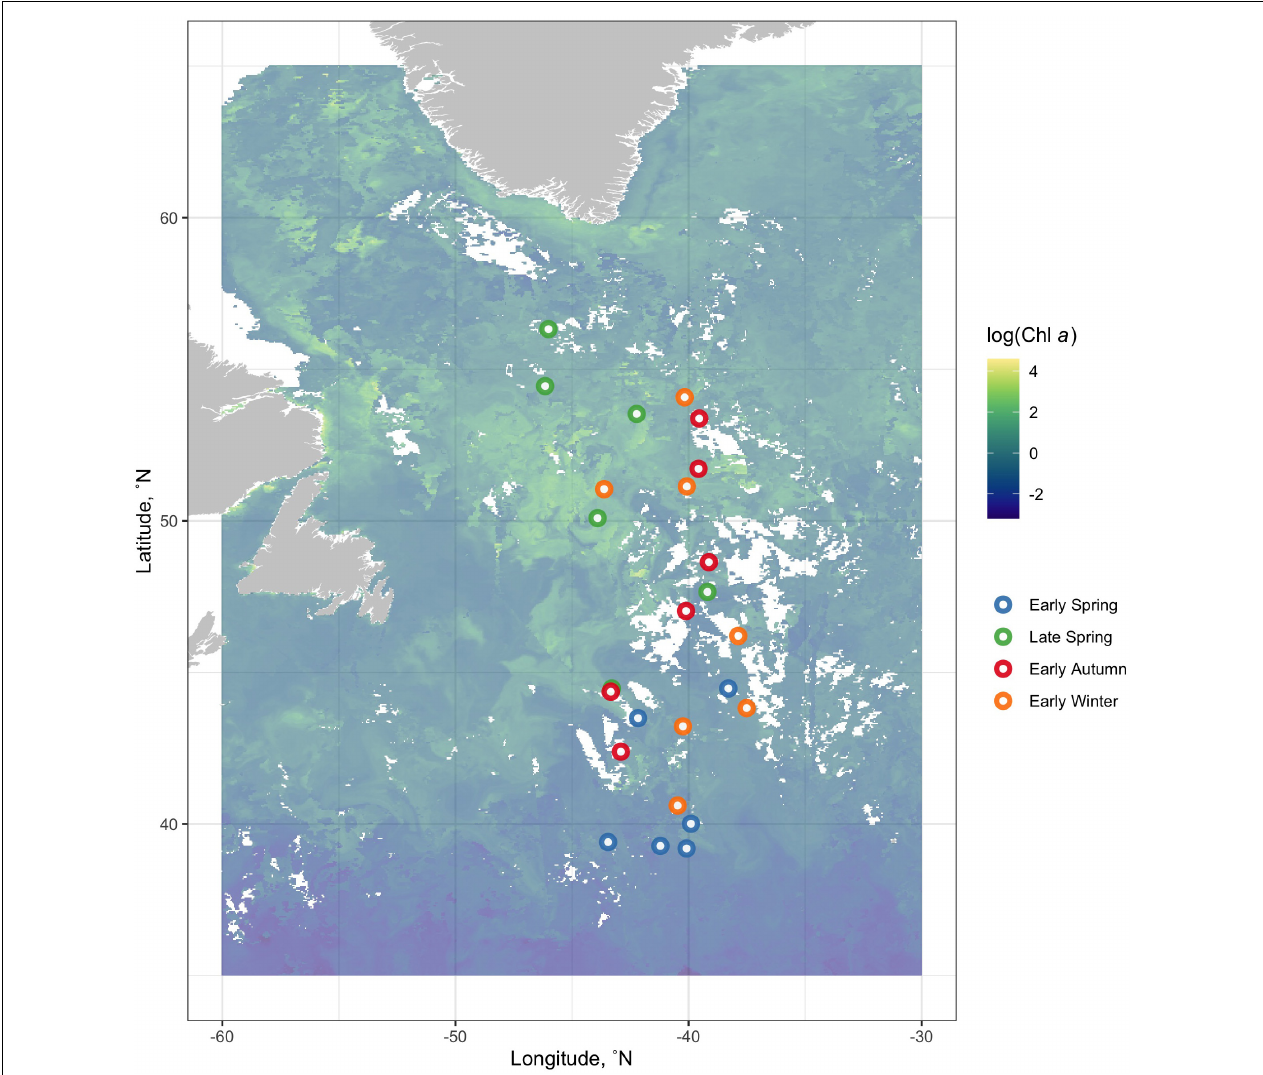
FIGURE 1 | Station locations for all cruises are overlain on a map of 8-day composite log-transformed chlorophyll data from NASA’s Moderate Imaging Spectroradiometer (MODIS) collected during May 2016. NAAMES 1 occurred in the early winter (“winter transition”: November–December 2015, orange points), NAAMES 2 in the late spring (“climax transition”: May 2016, green points), NAAMES 3 in the early autumn (“depletion phase”: September 2017, red points), and NAAMES 4 in the early spring (“accumulation phase”: April 2018, blue points).